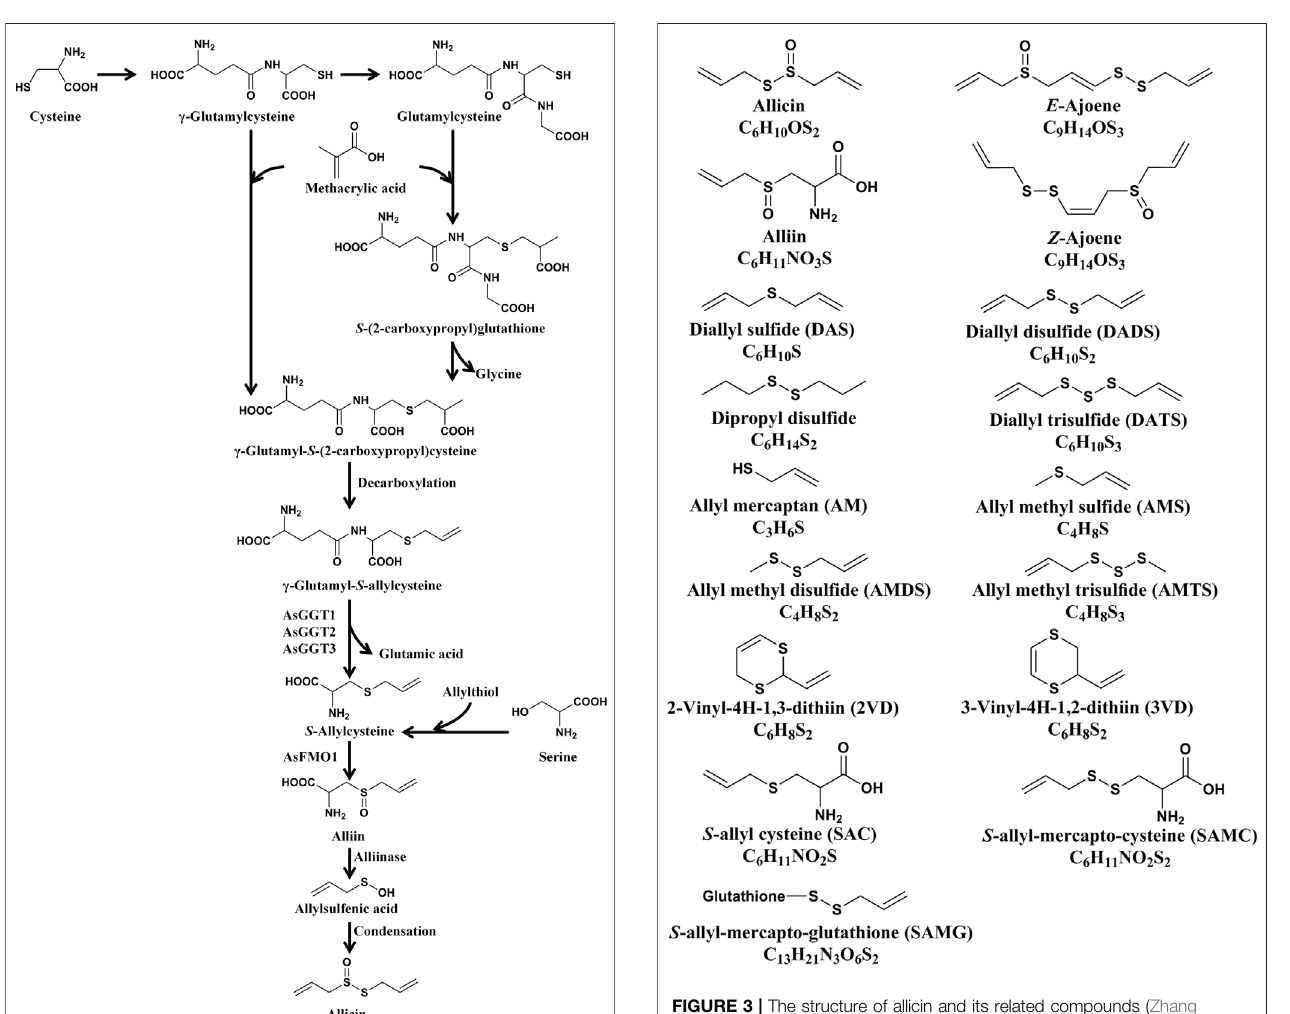
FIGURE 3 | The structure of allicin and its related compounds (Zhang et al.,